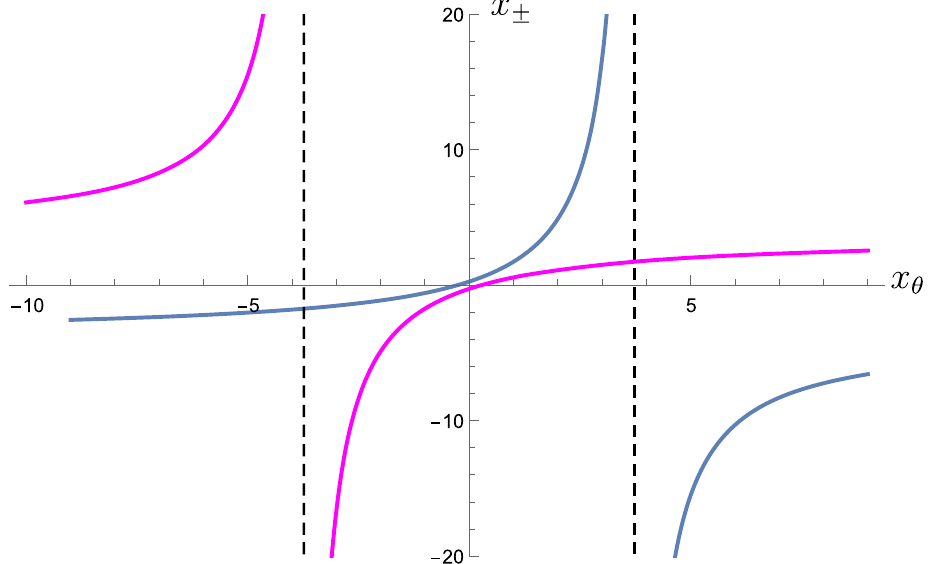
through infinity, x θ = ± x ∞ , are clearly visible. It is only in the middle region of the plot, ( − x ∞ , x ∞ ) , that the endpoints are in the canonical order x − < x